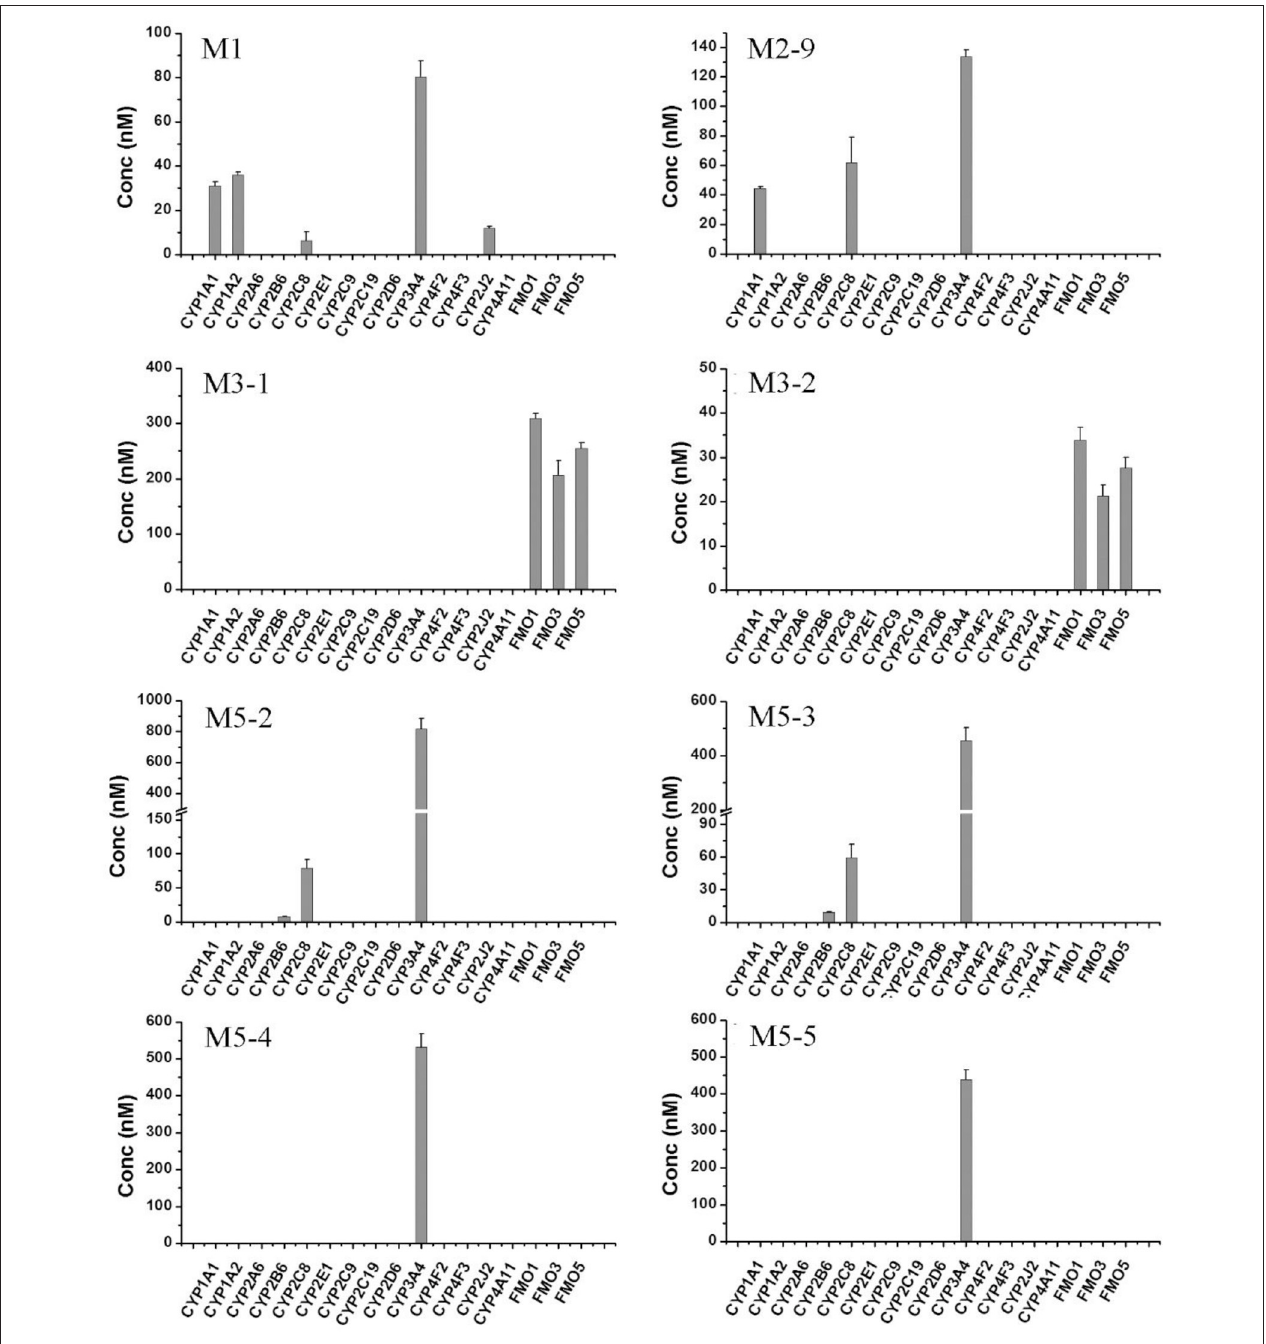
FIGURE 6 | Formation of F18 metabolites in human recombinant CYP450s and FMOs. F18 (10 µ M) was incubated individually with cDNA-expressed human CYP450 isozymes (50 pmol/mL CYP1A1, 1A2, 2A6, 2B6, 2C8, 2C9, 2C19, 2D6, 2E1, 2J2, 3A4, 4F2,4F3, or 4A11) or cDNA-expressed FMO enzymes (50 pmol/mL FMO1, FMO3, or FMO5) for 1 h. Each data represents the mean ± SD from three independent experiments.